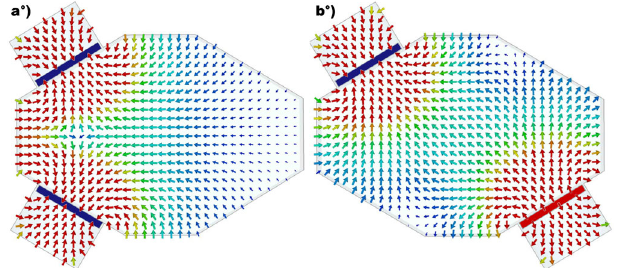
5. Transverse electric field created by a clearing electrode composed of two buttons. The color scale for the arrows is linear from red, E ¼ 20 kV = m, to blue, E ¼ 0 kV = m. Electrode (a): configuration − n − , the two buttons are negatively polarized, U ¼ − 0 . 5 kV. Electrode (b): configuration − nþ the upper button is negatively polarized, U ¼ − 0 . 5 kV, and the lower button is positively polarized, U ¼ 0 . 5